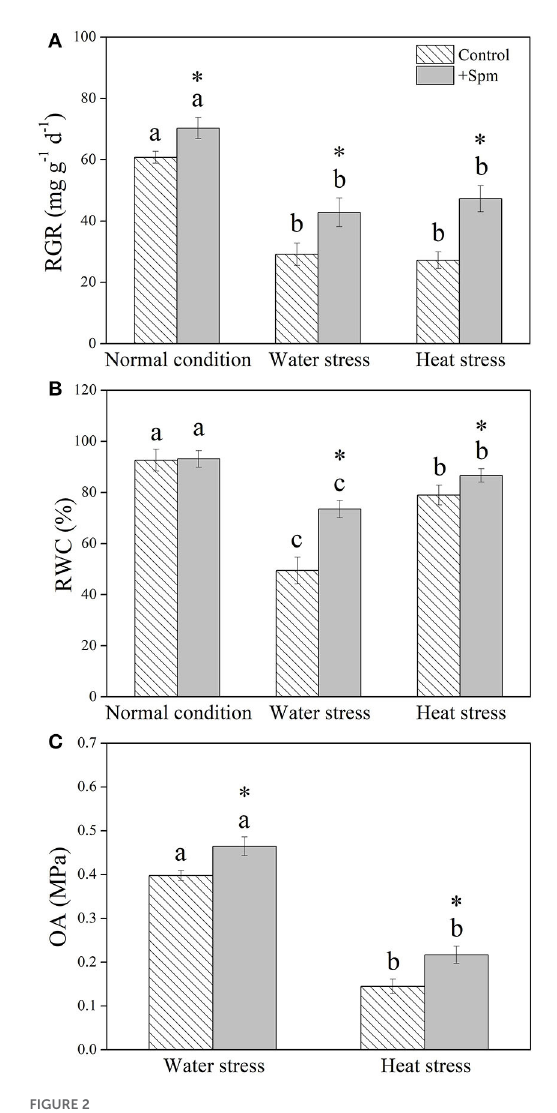
FIGURE2 Changes in (A) relative growth rate (RGR), (B) relative water content (RWC), and (C) osmotic adjustment (OA) in response to Spm application under different conditions. Vertical bars indicate ± SE of mean ( n = 4). Different letters above striated or gray columns indicate significant differences for a particular treatment (Control or + Spm) for comparison across the normal condition, water stress, and heat stress; the asterisk “*” indicates significant differences between the control and the + Spm treatments under one particular condition (normal condition, water stress, or heat stress) based on LSD ( P < 0.05).